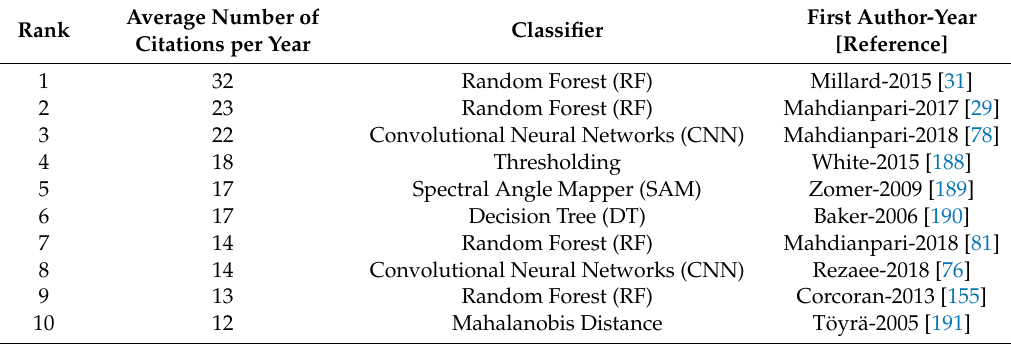
Table 3. Wetland classification articles ranked by number of citations normalized by years (as of 18 September